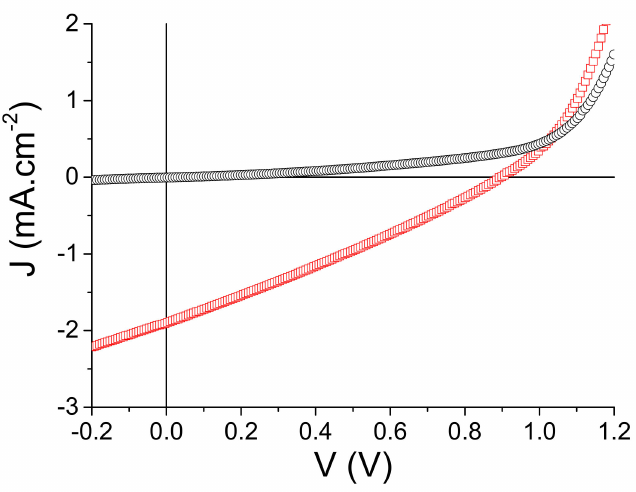
Figure 6. J–V characteristics of the BDT-C 60 based single component organic solar cell in the dark (black circles) and under an AM. 1.5 simulated solar illumination at 100 mW · cm −